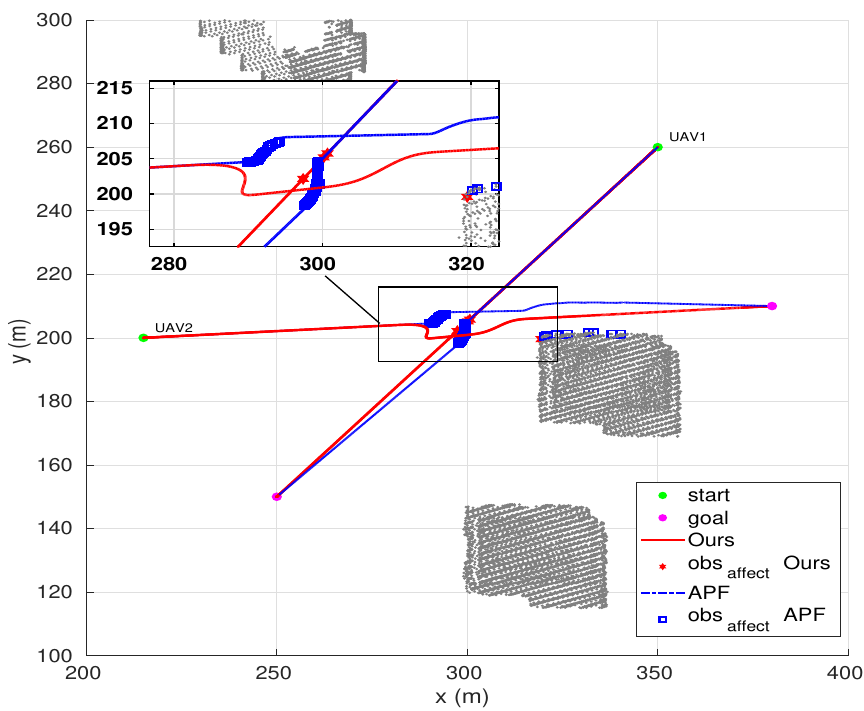
Figure 18. Bird’s eye view of the complex environment case.